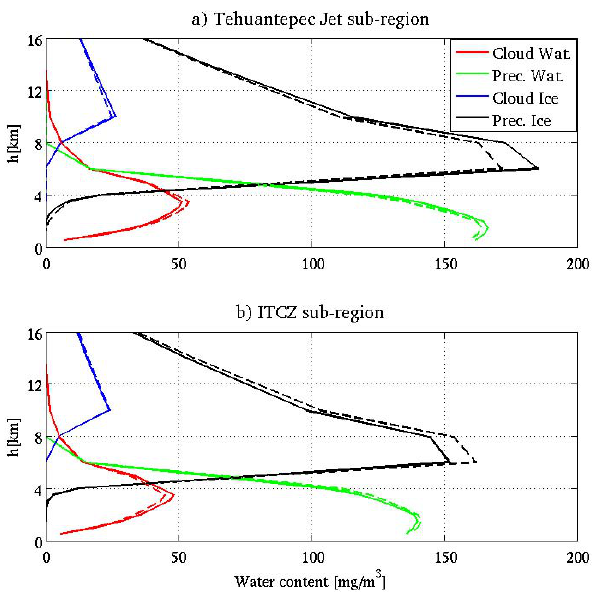
Fig. 6. Hydrometeor vertical profiles of precipitating clouds av- eraged over four summer months (June to September) for: (a) Tehuantepec Jet and (b) ITCZ sub-regions over the Pacific Ocean. Solid lines correspond to daytime profiles (06:00a.m.–06:00p.m.) and dashed lines correspond to nighttime profiles (06:00p.m.– 06:00a.m.).